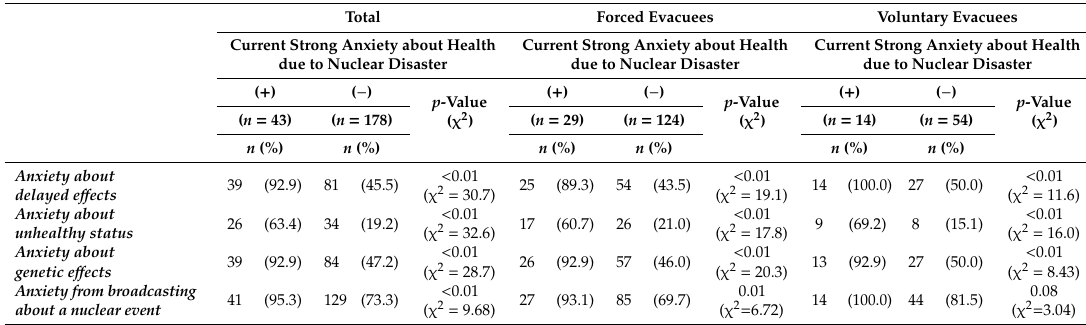
Table 3. Characteristics of current anxiety (forced / voluntary